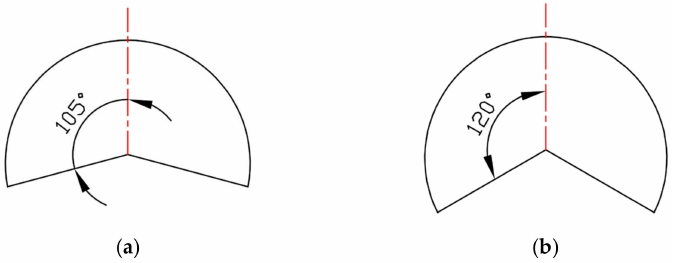
Figure 10. 15 ◦ cross angle susceptor with two different geometries (susceptor top view): ( a ) outer angle 105 ◦ and ( b ) outer angle 120 ◦ .